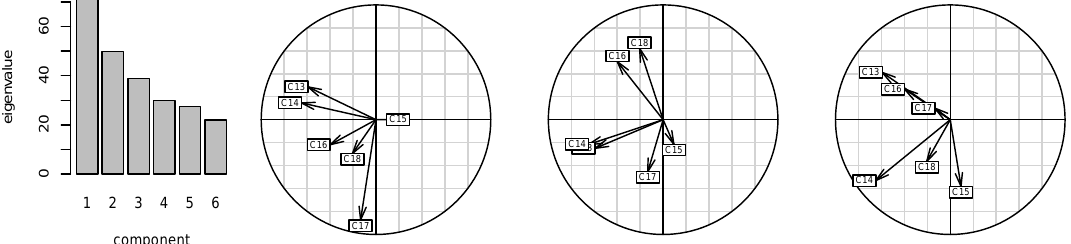
Figure 4. Principal component analysis (PCA) of 13 C chemical shift data obtained from the QM/MM MD simulations. From left to right: eigenvalues, components with PC 1 as abscissa and PC 2, 3, 4 as ordinate, respectively. PC 1–4 contain a cumulative projected inertia of